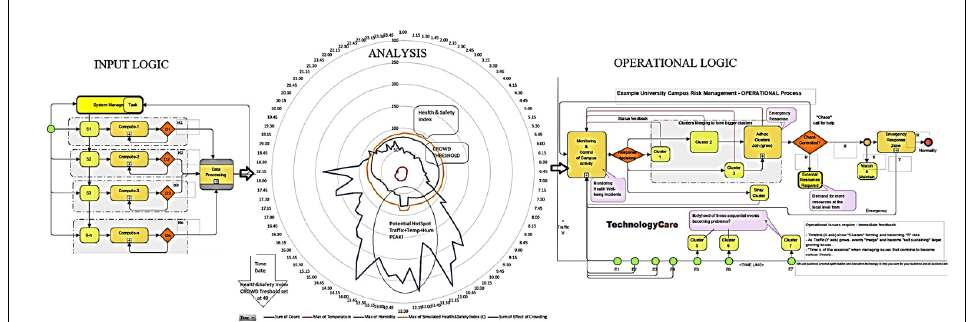
Figure 32. The fusion dashboard operational mode.